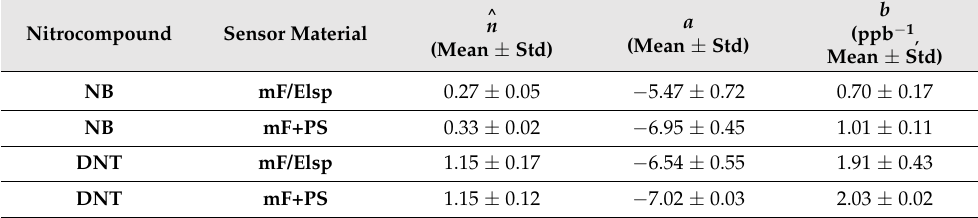
Table 2. Transport exponent estimates ˆ n and model parameters a , b for fluorescent materials mF/Elsp , mF+PS toward NB and 2,4-DNT in vapor